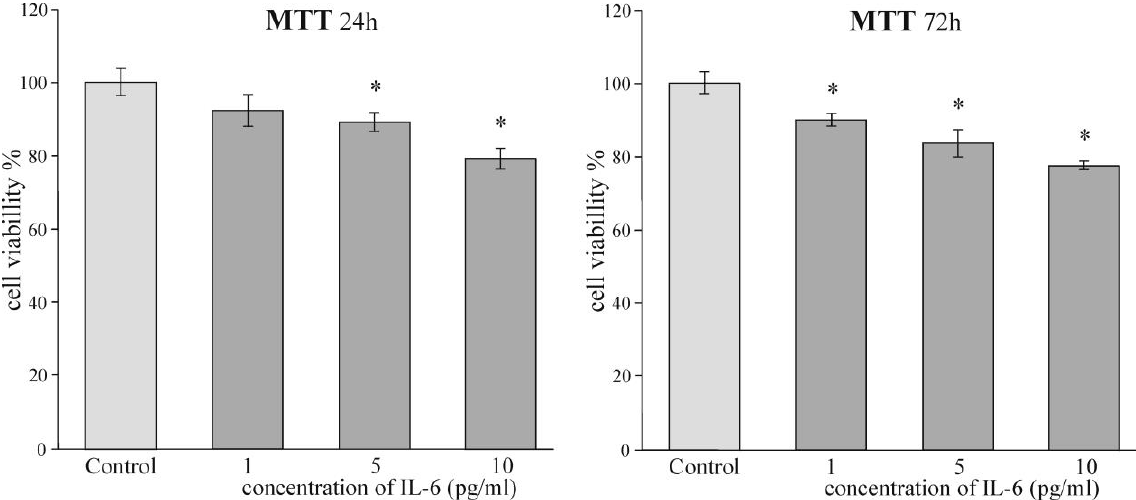
Figure 1. The effects of IL-6 on JEG-3 cell viability after 24 h and 72 h of treatment under chemically induced